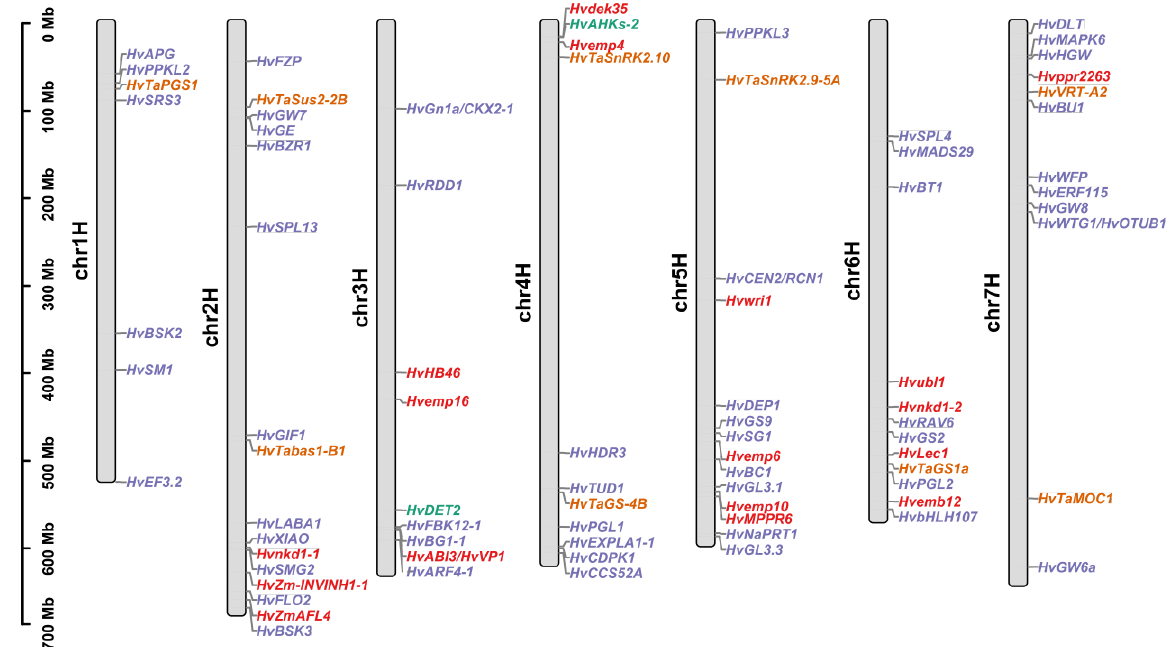
Figure 2. Distribution of the collinearity genes across seven barley chromosomes. The red font repre- sents the collinearity genes from maize, the green represents the collinearity genes from Arabidopsis , the orange represents the collinearity genes from wheat, and the purple represents the collinearity genes from